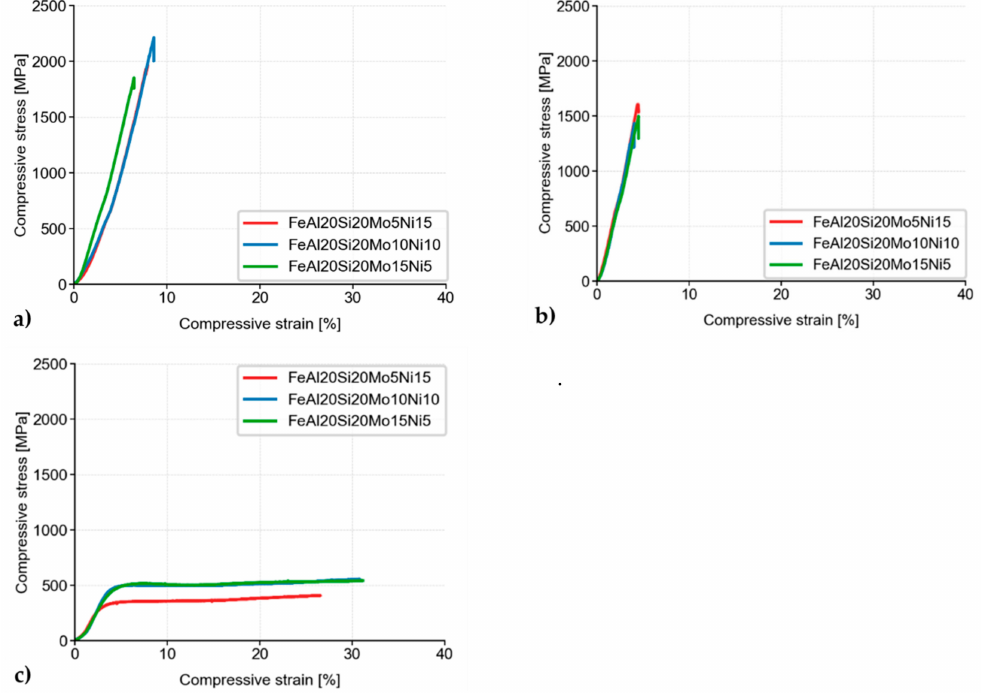
Figure 7. Compressive stress–strain curves of MA + SPS alloys at ( a ) laboratory temperature; ( b ) laboratory temperature after 100 h of annealing at 800 ◦ C; and ( c ) a temperature of 800 ◦